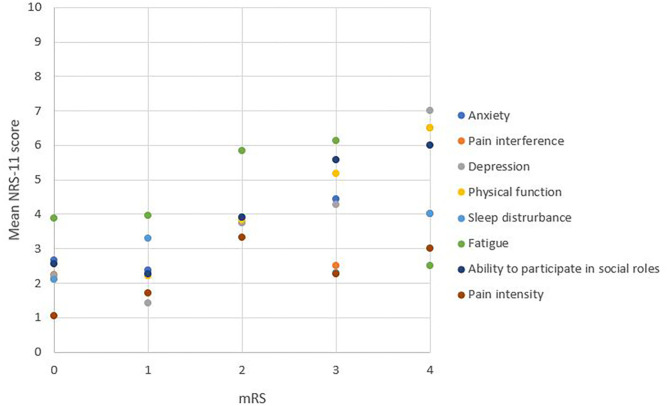
NRS-11 scale of each health domain across the levels of disability. One dot represents the mean score on the scale of zero to ten. A higher NRS-11 score represents worse patient-reported health.